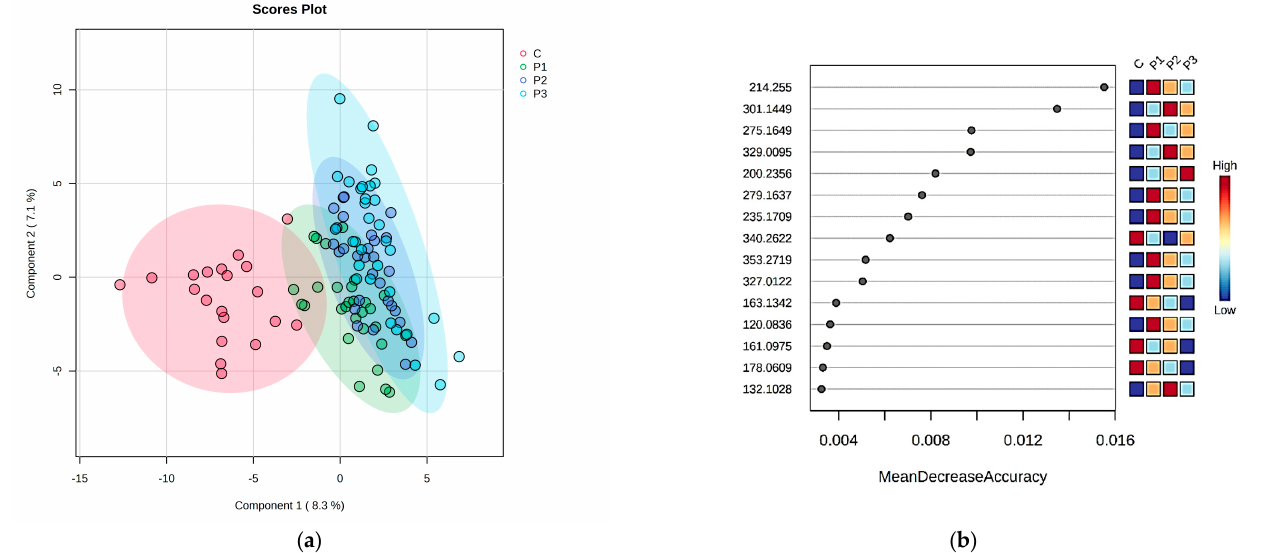
Figure 4. Univariate analysis of urine samples; ( a ) PLSDA score plot of urine samples; ( b ) Random Forest-MDA score of urine samples.